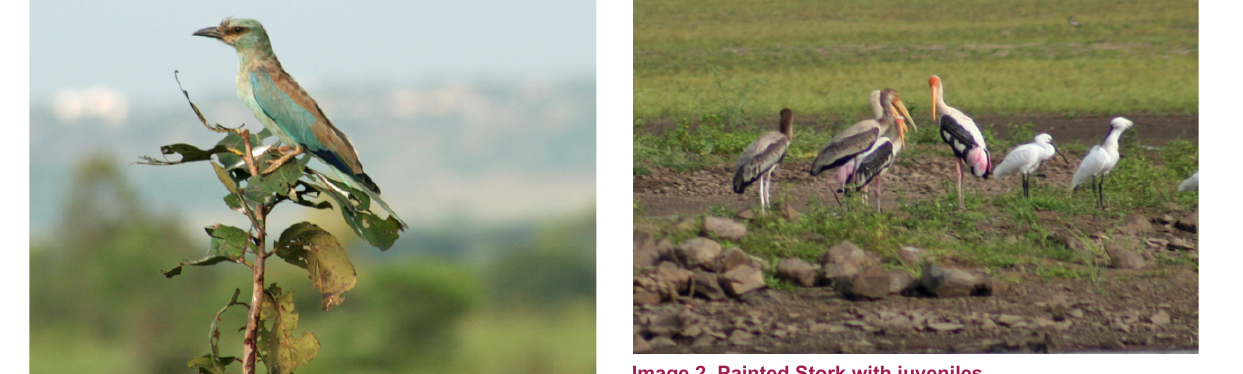
Image 2. Painted Stork with juveniles